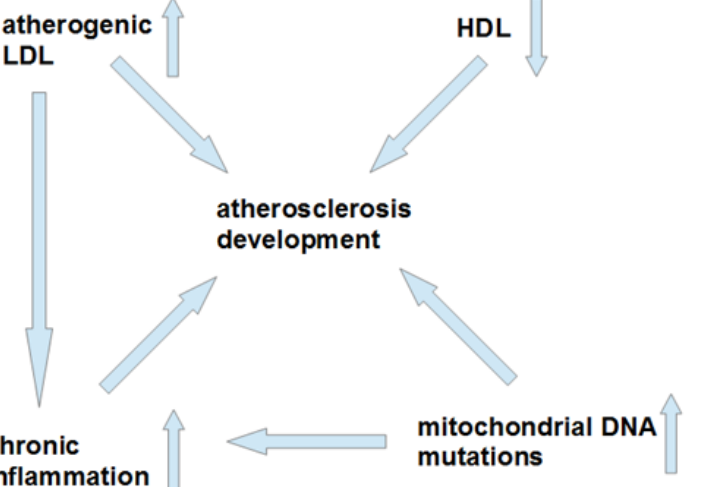
Figure 1. Factors associated with atherosclerosis development and their connections with each other. Chronic inflammation is connected with atherogenic LDL and mitochondrial DNA mutations and, thus, it could be that inflammation is a central component in atherosclerosis pathogenicity. However, we must mention that the exact details of interactions of all these factors with each other (especially, HDL) are still to be clarified in the future. LDL—low-density lipoproteins, HDL—high-density